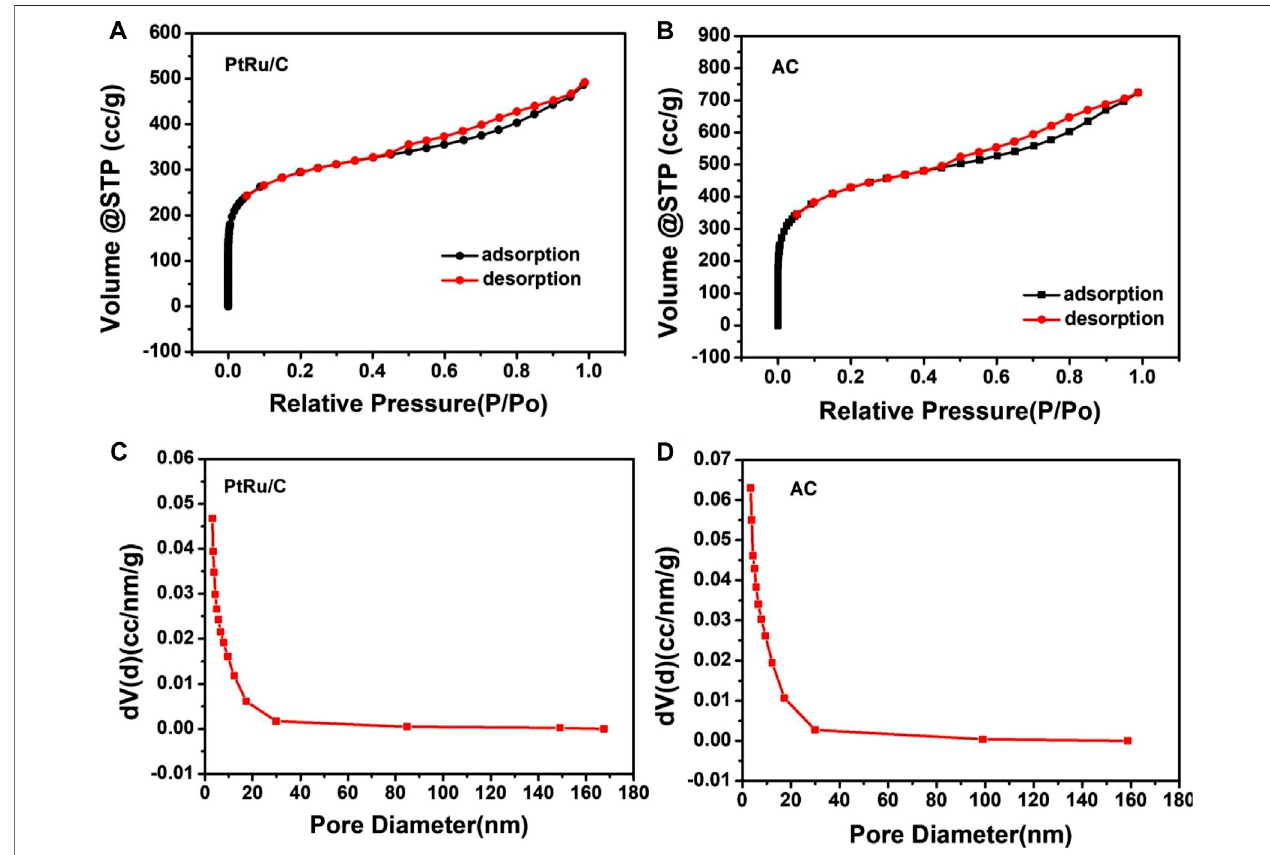
FIGURE3| Nitrogenadsorption/desorptionisothermsof (A) PtRu/C-0.75and (B) ACsamples,porediameterdistributionof (C) PtRu/C-0.75and (D) ACsamples.